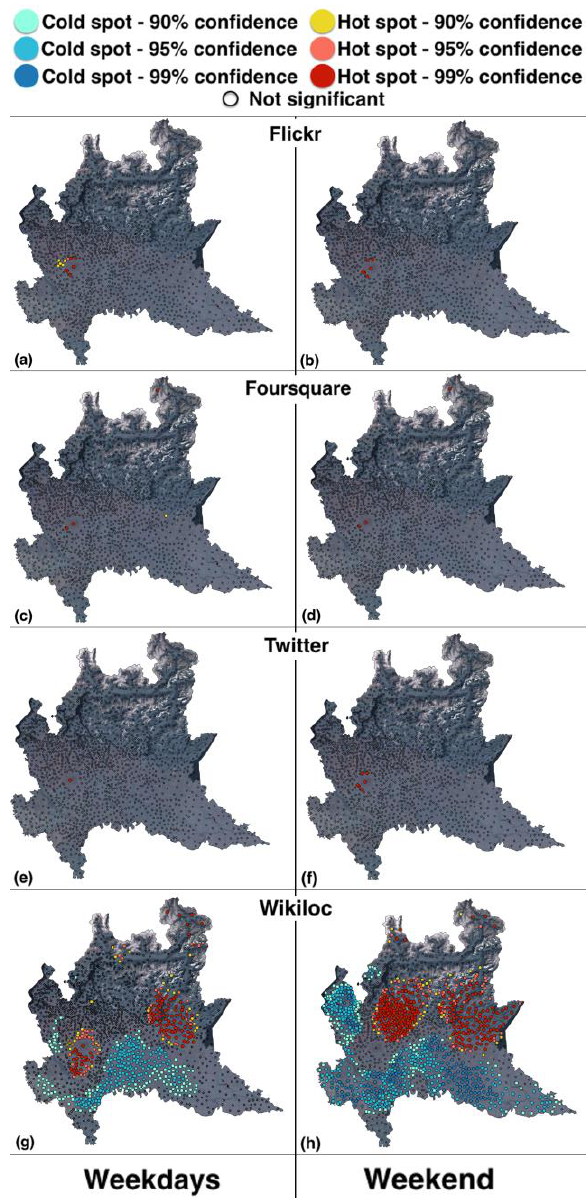
Figure 3. Hot spot analysis with different confidence levels for the different datasets of the selected platforms during weekdays and weekends. (© 2016